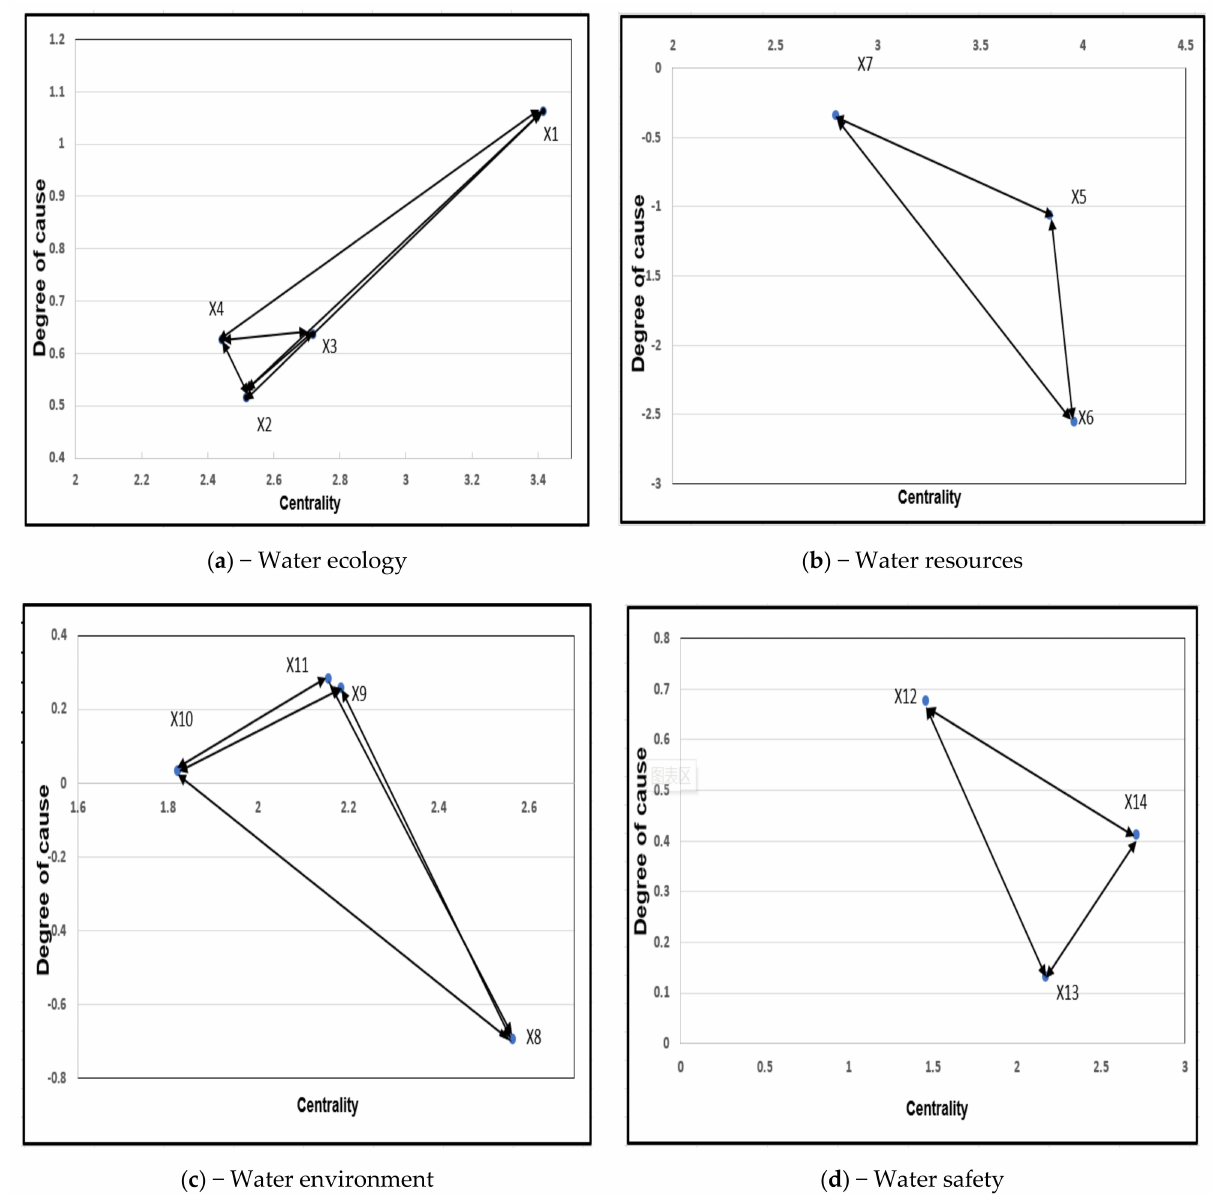
Figure 6. Evaluation index of urban water